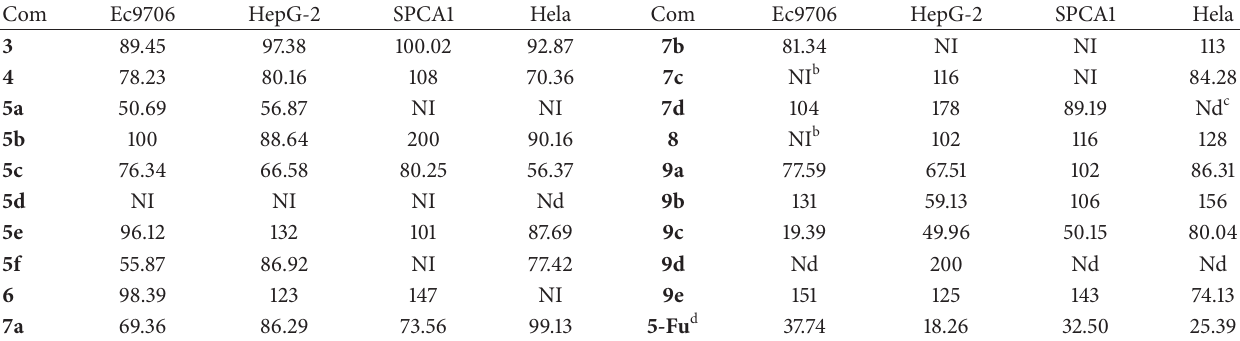
Table 2: a IC values of butenolides against Ec9706 cells, Hela cells, SPCA1 cells and HepG-2 50